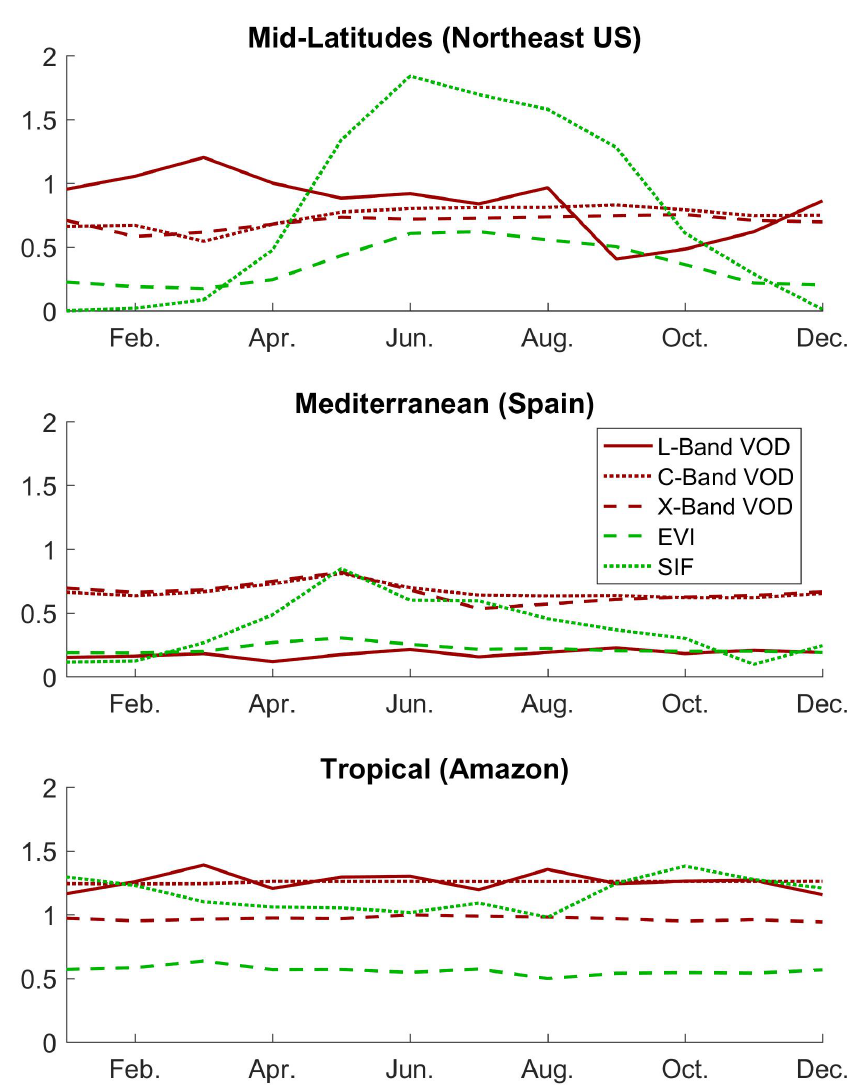
Figure 16. Seasonal cycles over different climates ( top : energy limited—northeastern US, middle : Mediterranean climate in Spain, bottom : rainforest in the Amazon) as assessed using different sources of data: Vegetation Optical Depth (VOD) at high (X-band), medium (C-band) or low frequency (L-band), Enhanced Vegetation Index (EVI) and Solar-Induced Fluorescence (SIF) using the GOME-2 satellite